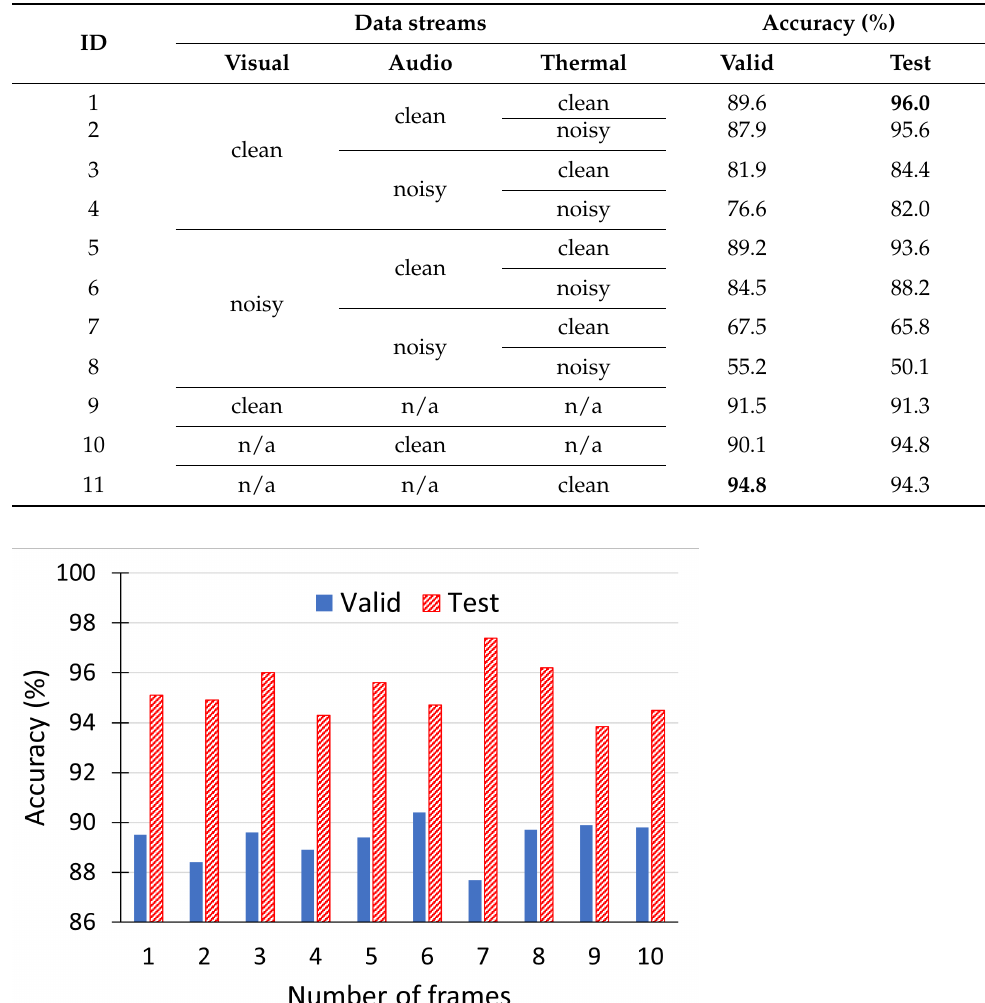
Table 4. The accuracy of multimodal gender classification model evaluated on the clean and noisy input data streams. ‘n/a’ stands for not available. The best accuracy results for the validation and test sets are boldfaced.